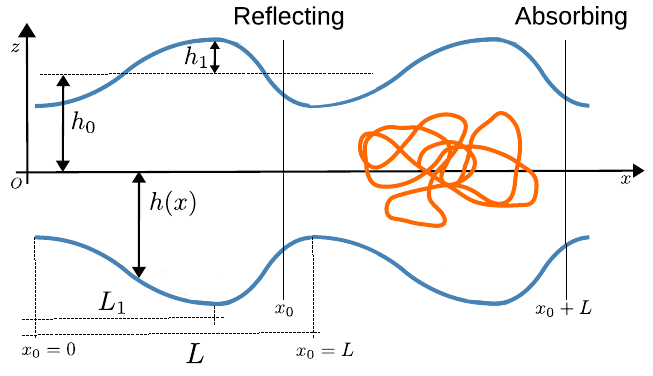
Figure 1. A polymer (orange curve) in a channel with a periodically-varying cross-section and impermeable walls (blue solid curves). The bottlenecks of the channel have half-thickness h 0 − h 1 , (see Equation (2)), while the half-thickness of broad chambers is equal to h 0 + h 1 . The first bottleneck on the left-hand-side of the channels is fixed to be located at the origin O , i.e., x = 0. The vertical lines x 0 and x 0 + L indicate the positions of the reflecting and absorbing boundaries, respectively. Varying x 0 at a fixed profile h ( x ) , we quantify the effect of a relative position of the absorbing/reflecting boundaries with respect to the bottlenecks and chambers of the channel onto the effective broadness of the first-passage time distribution (FPTD), as probed here by the value of γ